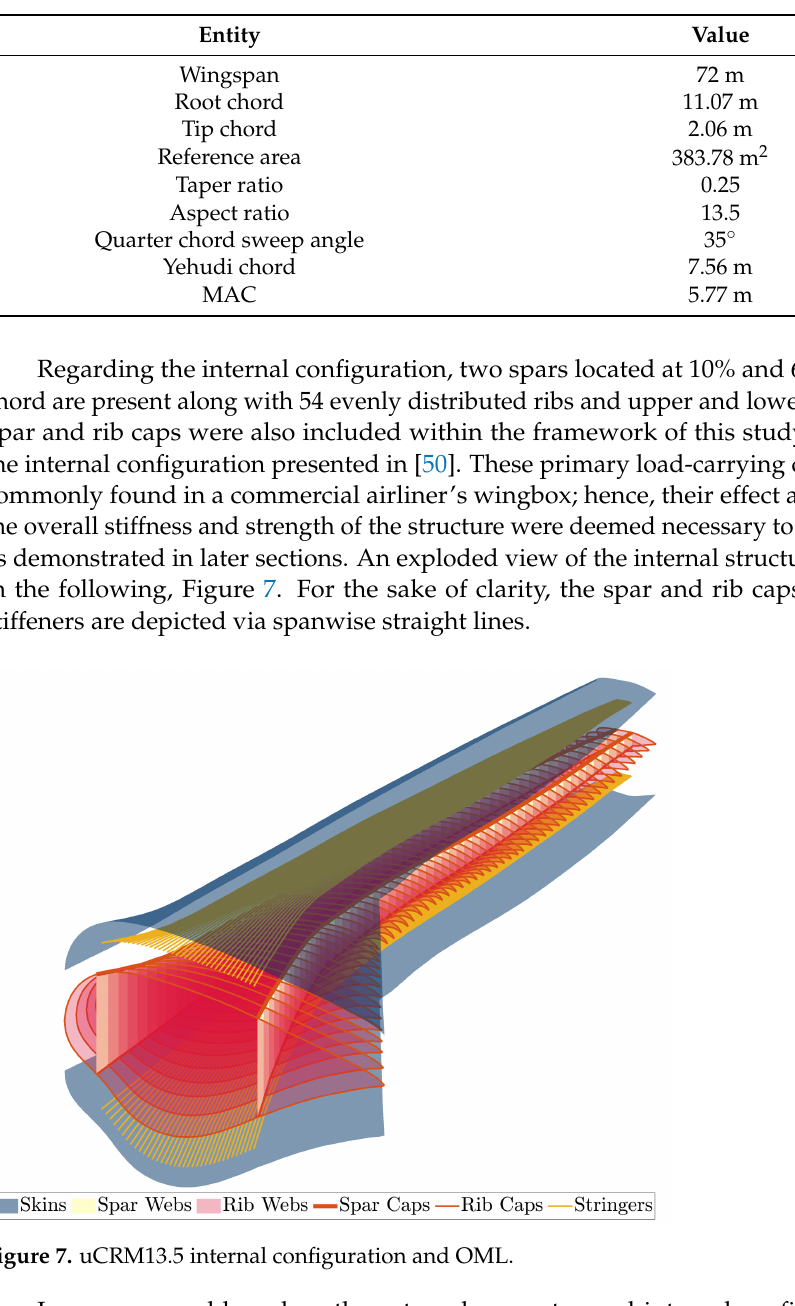
Table 4. uCRM-13.5 geometric characteristics.